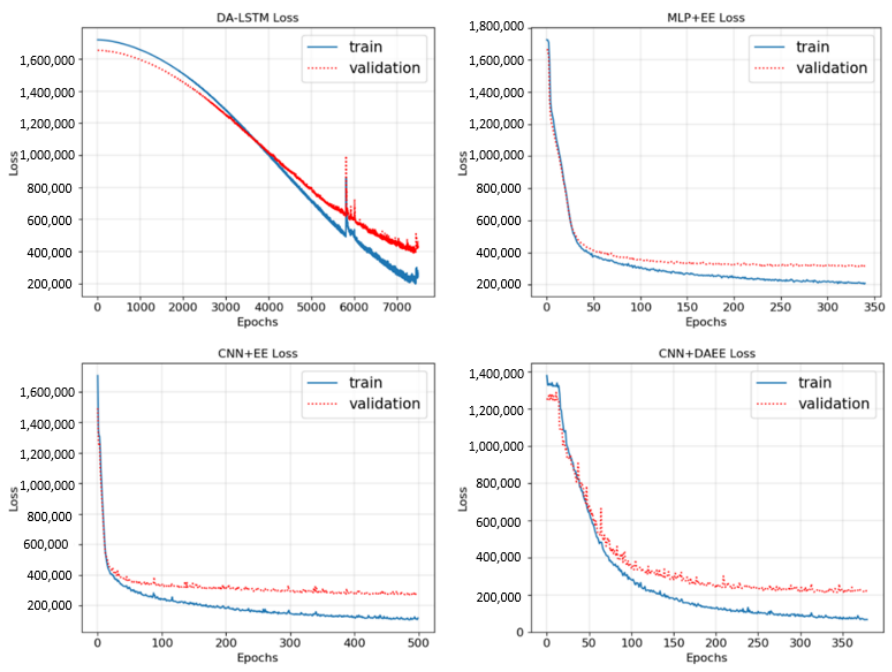
Figure 6. Training and validation loss curves of four models.